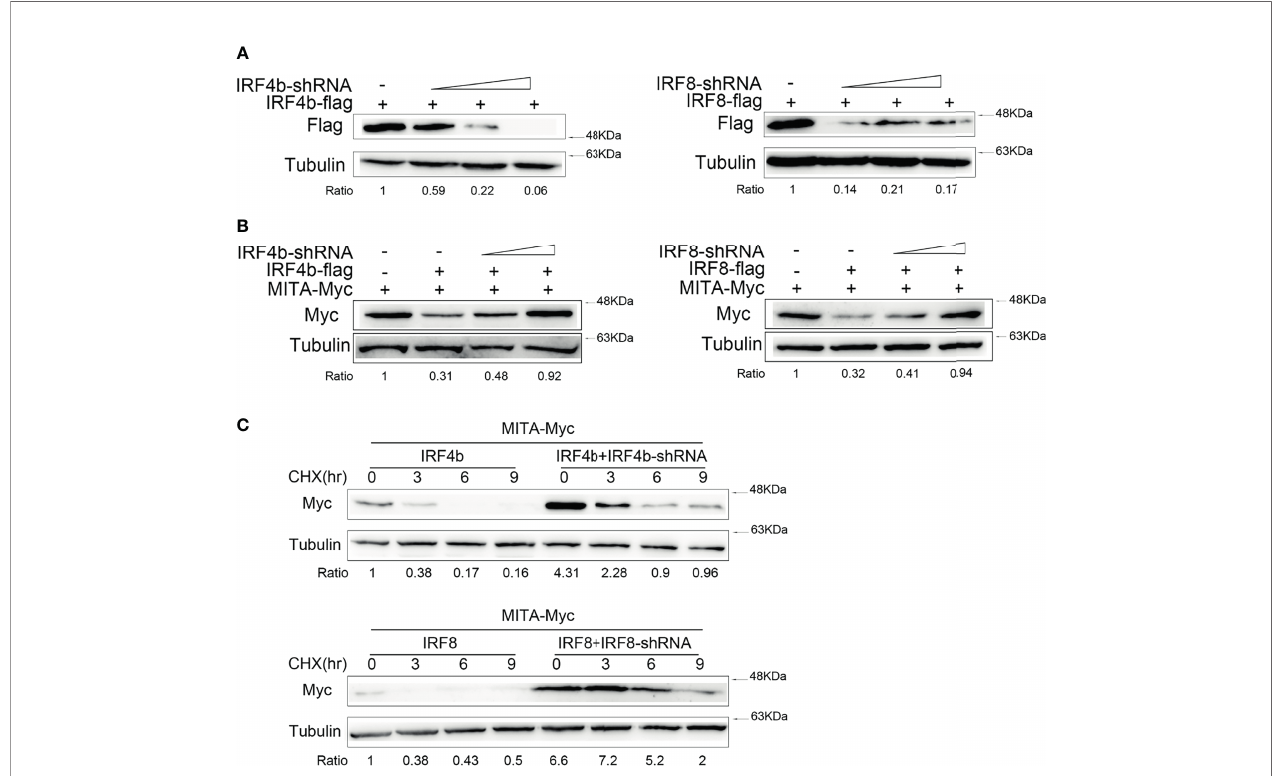
FIGURE 4 | Effects of the knockdown of IRF4b or IRF8 on MITA. (A) The validity of IRF4b-shRNA or IRF8-shRNA was checked after transfecting IRF4b and IRF4b- shRNA or IRF8 and IRF8-shRNA into EPC cells, and the expression of IRF4b or IRF8 was examined by immunoblot assays at 24 h after transfection. (B) MITA and IRF4b were cotransfected with IRF4b-shRNA (0.2 and 0.4 m g) into EPC cells, and MITA, IRF8, and IRF8-shRNA were transfected in the same way as MITA, IRF4b, and IRF4b-shRNA. The expression of MITA was then measured by immunoblot assays. (C) EPC cells were transfected with MITA, IRF4b and IRF4b-shRNA, or IRF8 and IRF8-shRNA, and the cells were treated with CHX (100 µg/ml) at 24 h after transfection and lysed every 3 h. The protein level of MITA was examined by immunoblot assays. All the experiments were performed independently at least three